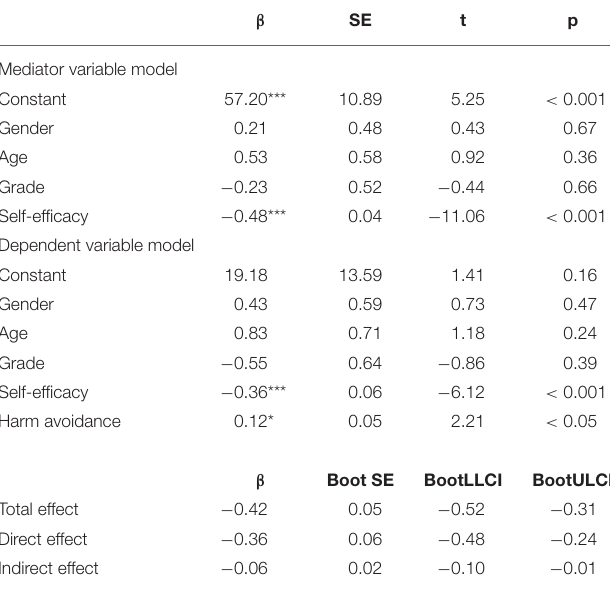
TABLE 3 | Moderated mediation analysis for self-efficacy, HA, BP, and novelty seeking